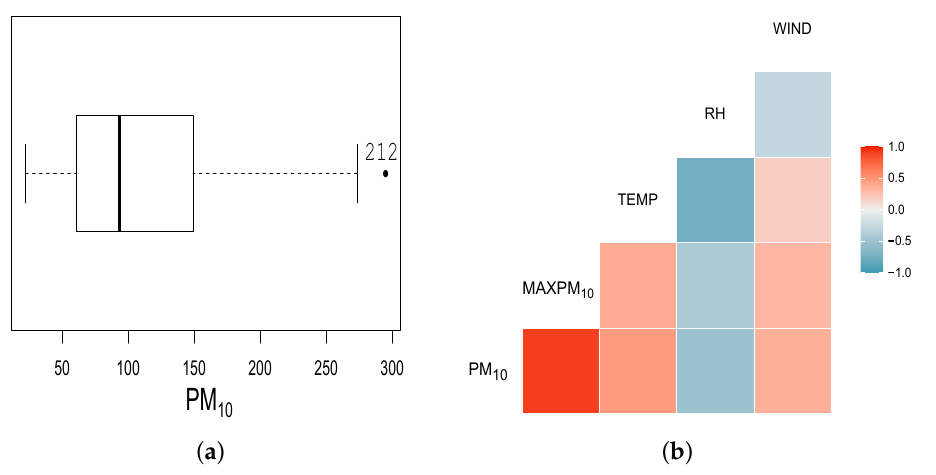
Figure 9. Boxplot for PM 10 levels recorded by the HCH monitoring station in Lima, Peru. ( a ) Boxplot for PM10 levels recorded by the HCH monitoring station in Lima, Peru, during 2017–2018 and ( b ) scatter plot with the corresponding correlations for the indicated explanatory variables and response variable.